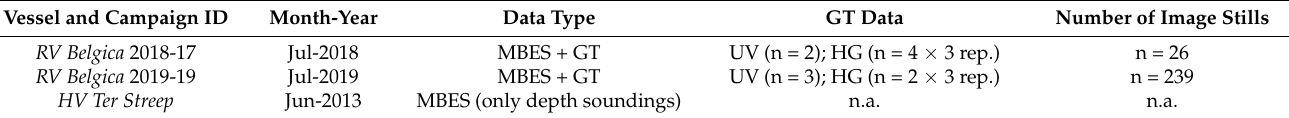
Table 1. Timeframe ID of the oceanographic campaigns, geophysical data type, ground truth data, and number of selected frames used for further analysis. RV = research vessel; MBES = multibeam echosounder (seafloor depth and backscatter); GT = ground truth; HG = Hamon grab; UV = underwater video; n.a. = not applicable; Rep. = replicate sample. Link to oceanographic campaign reports and course of actions available at RV Belgica web site: https://odnature.naturalsciences. be/belgica/en/(re: campaign